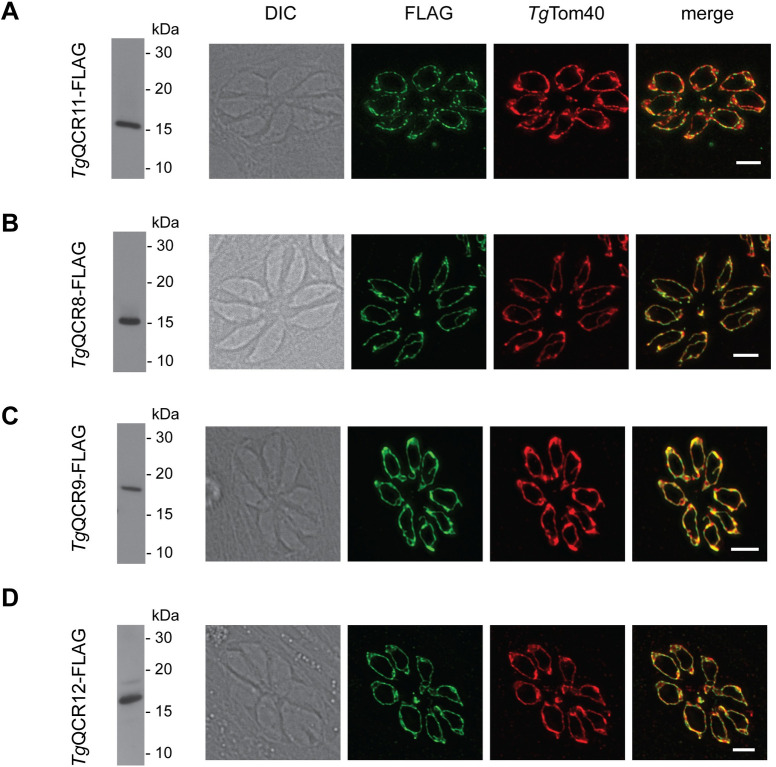
Candidate Complex III subunits localize to the mitochondrion of T. gondii.(Left) Western blot and (Right) immunofluorescence assay analysis of (A)
TgMPPα-HA/TgQCR11-FLAG, (B)
TgMPPα-HA/TgQCR8-FLAG, (C)
TgMPPα-HA/TgQCR9-FLAG, or (D)
TgMPPα-HA/TgQCR12-FLAG parasites. Western blots were detected with anti-FLAG antibodies, and immunofluorescence assays were detected with anti-FLAG (green) and the mitochondrial marker anti-TgTom40 (red) antibodies. Scale bars represent 2 μm.